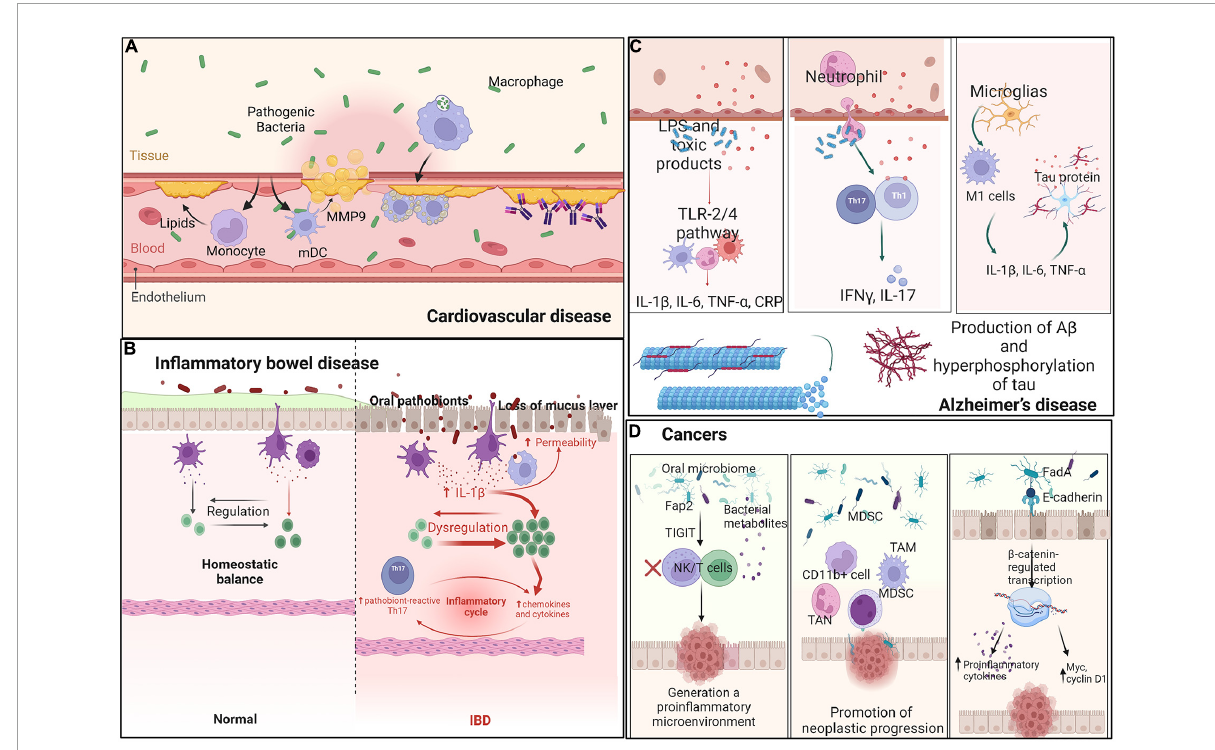
FIGURE3 Interaction between oral microbes and immune cells in distant organs. Ectopic oral pathogens travel through other parts of the body, triggering inflammatory diseases. (A) Cardiovascular disease: Oral microbiota recruit monocytes and mDCs and secrete MMP-9 and lipids. Heat-shock proteins and antibodies against b2GP1 and oxLDL promote myocardial infarction. (B) Inflammatory bowel disease: Oral pathobionts translocate to the gut and promote colitis through induction of inflammasome-dependent IL-1 β secretion and oral pathobiont-reactive Th17 cells. (C) Alzheimer’s disease: Oral pathobionts increase the production of A β and hyperphosphorylation of tau via the TLR-2 and TLR-4 signaling pathways, thereby increasing the levels of IL-17 and IFN- γ produced by Th-cells. (D) Cancer: Oral microbes engage the TIGIT receptor of immune cells, decreasing the abundances of MDSCs, TANs, and TAMs and increasing oncogene expression to generate a proinflammatory